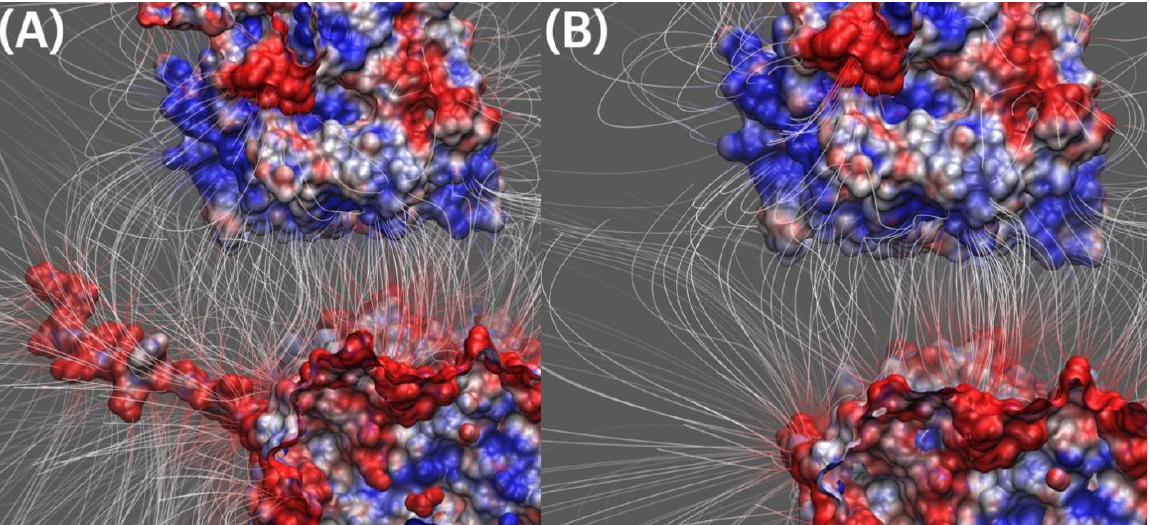
Figure 6. Field lines between kinesin and beta tubulin. ( A ) Kinesin and beta tubulin with E-hook; ( B ) Kinesin and beta tubulin without E-hook. Color scale: − 3.0 to 3.0 kT/e (red to blue).